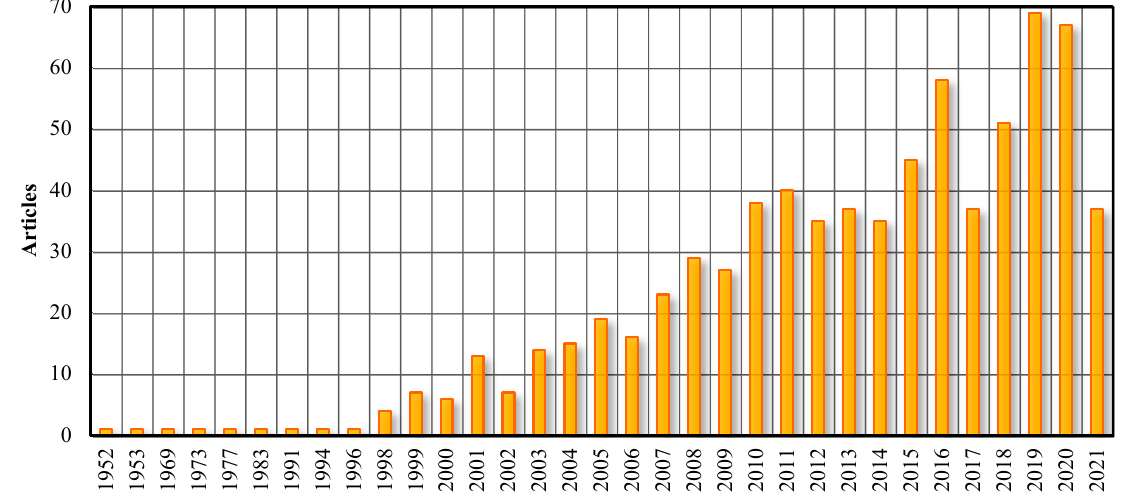
Figure 1. The increase in urban sprawl literature over the years.